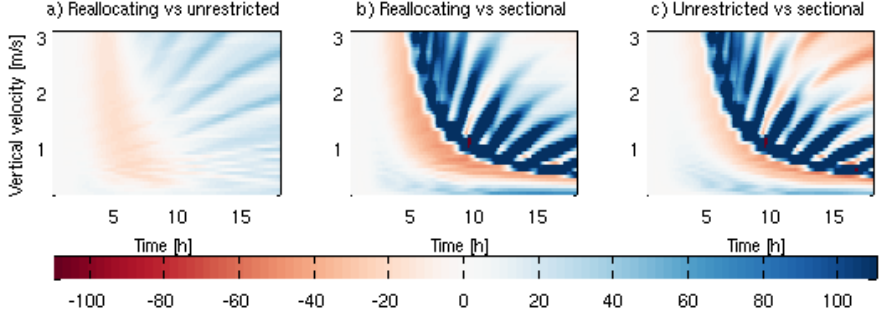
Fig. 11. The relative difference of the ACI parameter between the three models. The sharp mode in the sectional distribution together with the changes in the critical diameter cause the extreme differences compared to the modal models with fixed mode width